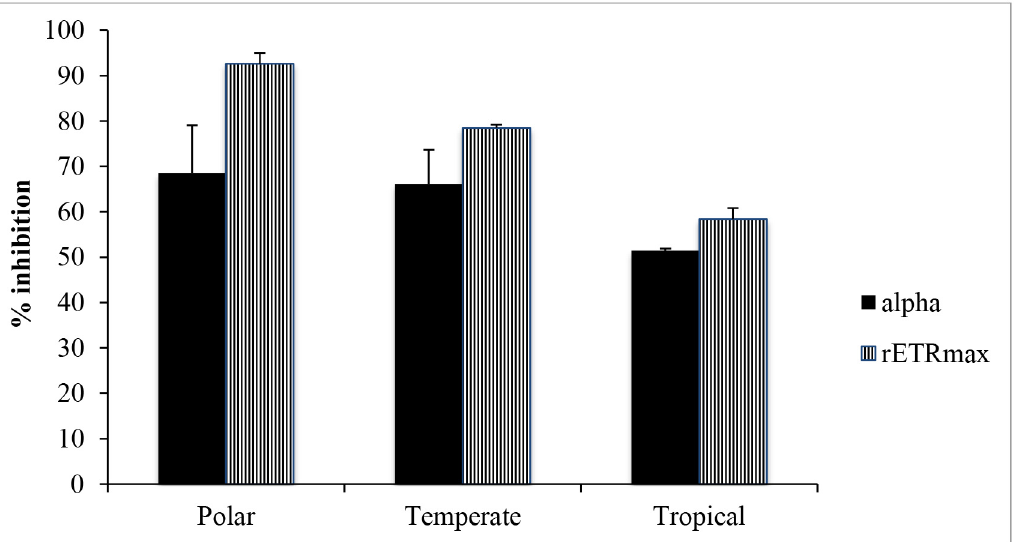
Fig 2. Inhibition of light harvesting efficiency (alpha) and maximal electron transport rate (rETR max ) of polar, temperate and tropical Chlorella grown at their optimum temperatures (18, 20 and 30°C, respectively) then exposed to PAR + UV-A + UV-B for 60 min. Vertical bars denote standard deviations from triplicate